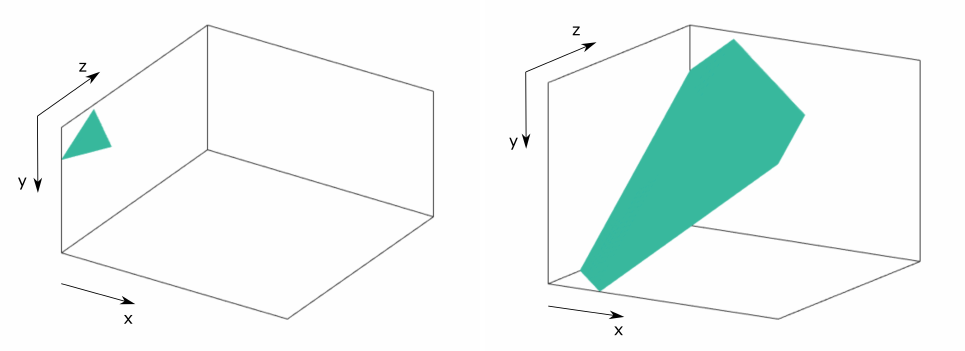
Figure 6. Example of isoplane layers for a 32 × 32 × 32 symbol 3D array. Left hand-side graph for K = 10 and right hand-side graph for K =